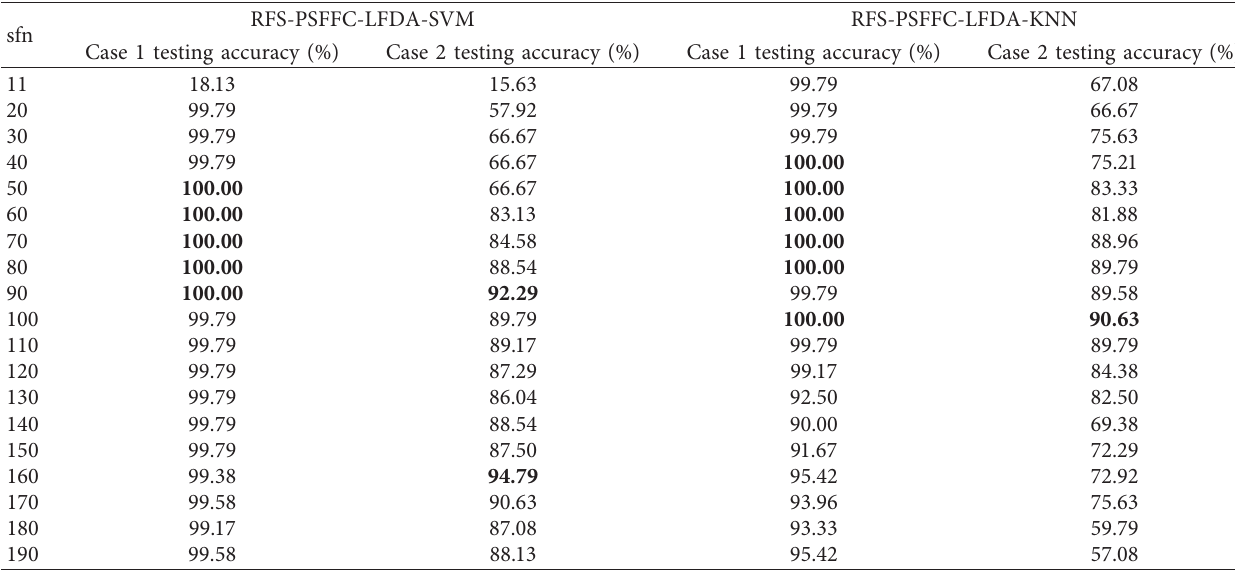
Table 10: The testing accuracies of RFS-PSFFC-LFDA-SVM and RFS-PSFFC-LFDA-KNN (the dimension size is 11). RFS-PSFFC-LFDA-SVM RFS-PSFFC-LFDA-KNN sfn Case 1 testing accuracy (%)